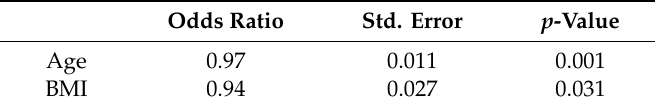
Table 3. Multivariate model for factors that predict the PON lactonase activity in patients with chronic kidney disease.